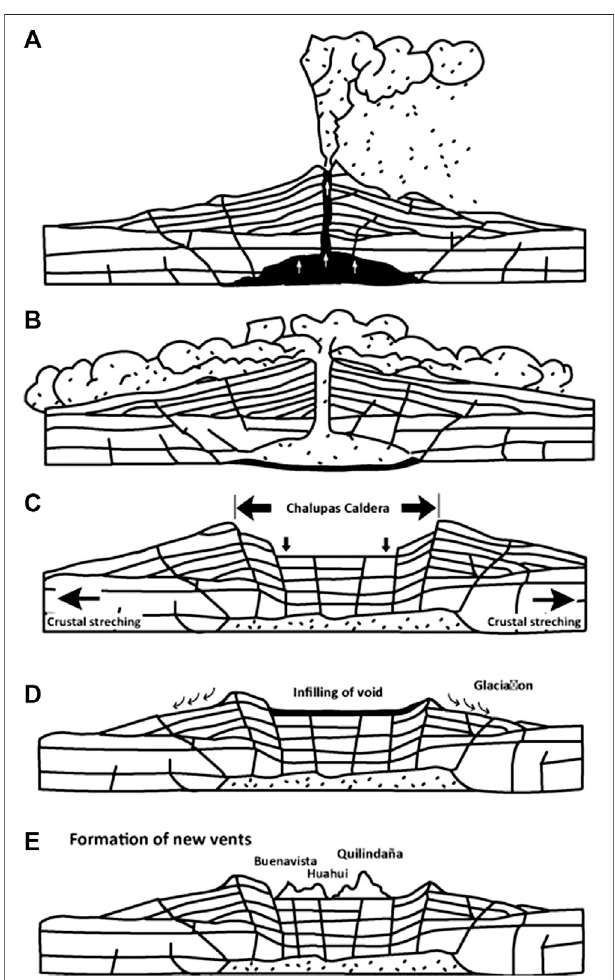
FIGURE 3 | Phases of formation of the Chalupas Caldera: (A) Upwelling of magma in center volcano, starting with a Plinian eruption column, with accompanying ring fracture andesitic cones forming outer boundary; (B) Magmaevacuatesthecalderaandexpulsesash- fl owsheetstotheE,W, S and N; (C) Collapse, foundering of caldera; (D) Erosion and in fi lling of void and glaciation; (E) Growth of Quilindaña peak, vent migration along dykes to the east and formation of Huahui vent and Buenavista lava